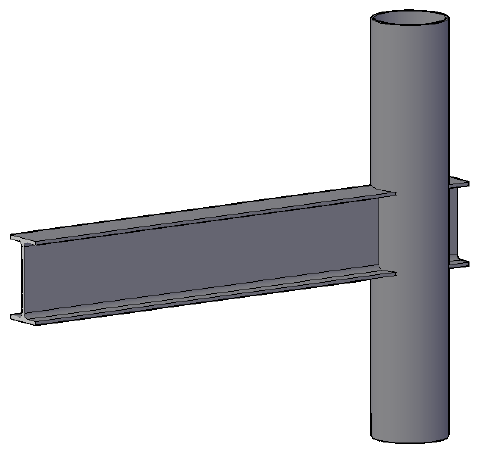
Figure 1. Connection between CHS column and passing-through double-tee beam.